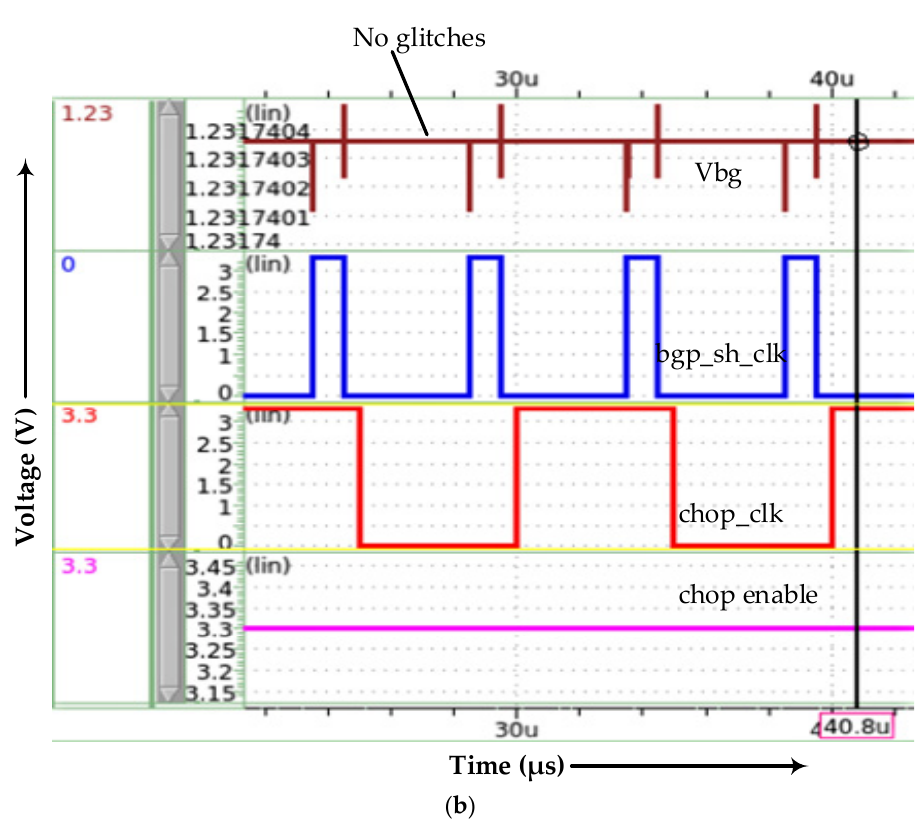
Figure 9. ( a ) Output Vbg without the chopper circuit; ( b ) output Vbg with the chopper circuit.